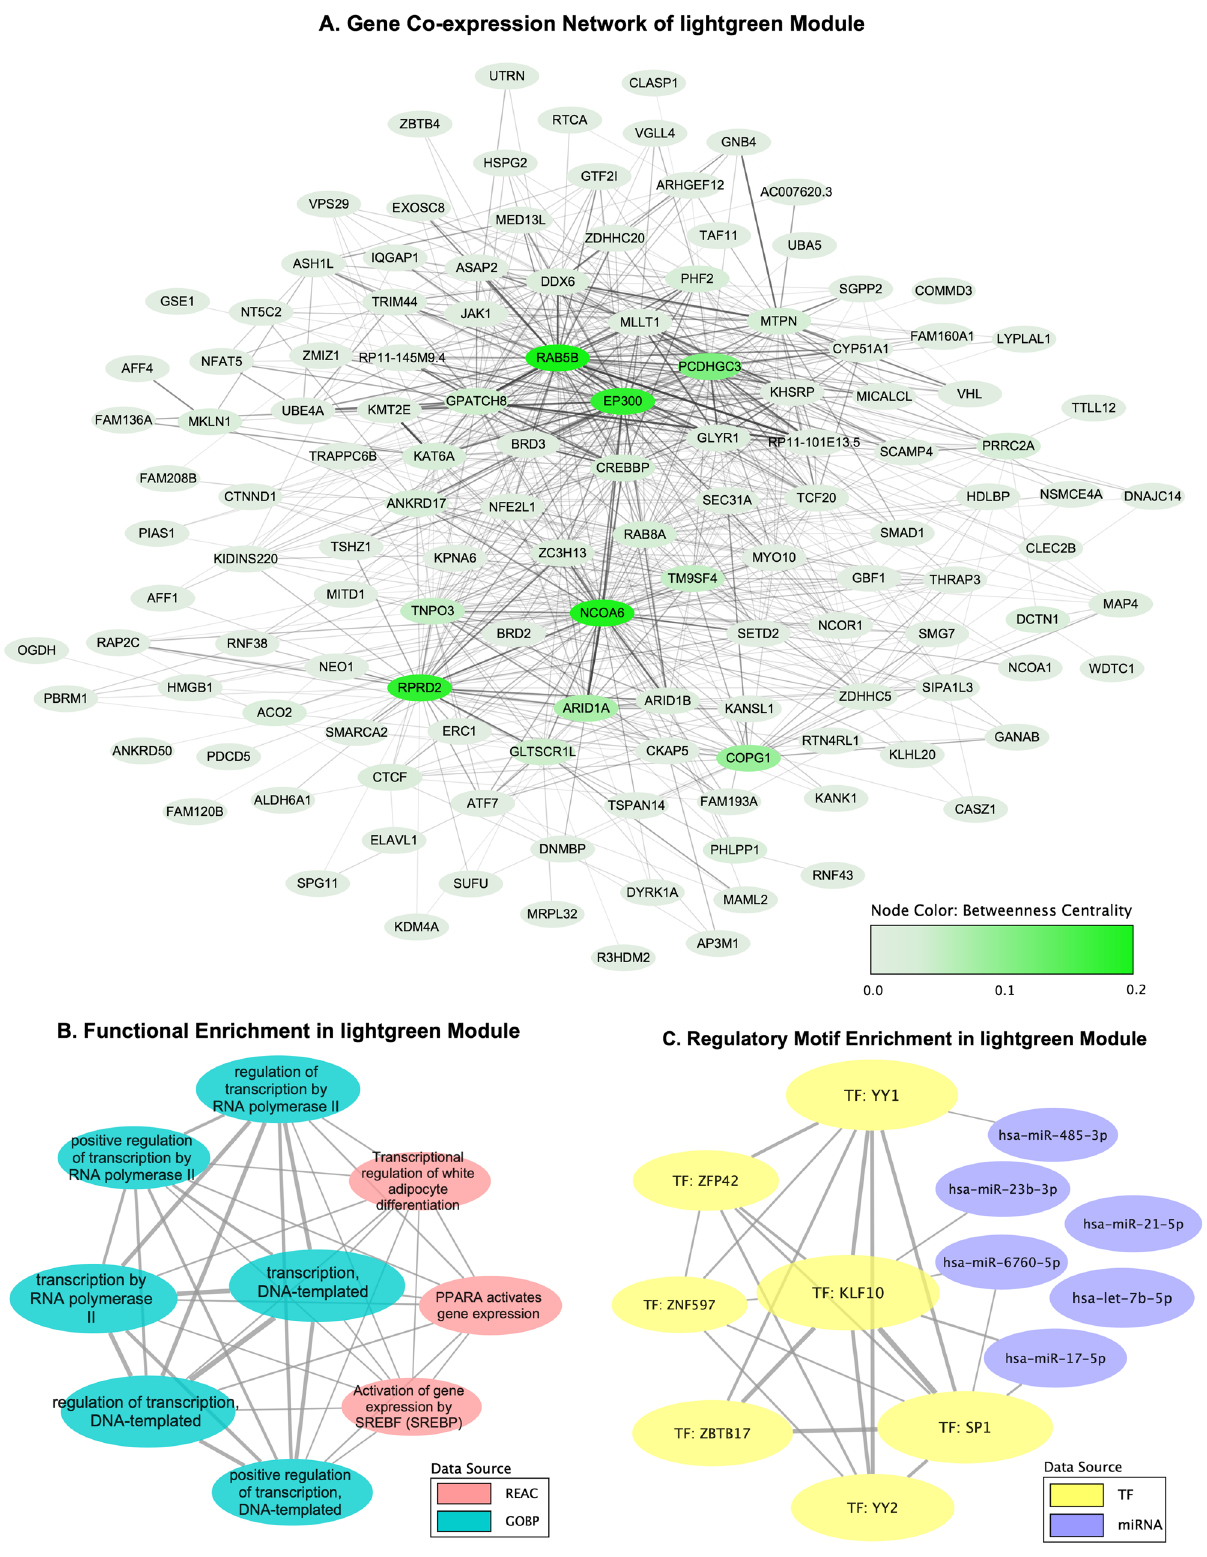
Figure 2. Intramodular analysis of lightgreen module. ( A ) Gene co-expression network of lightgreen module. ( B ) Functional enrichment of lightgreen module: each node is a gene set and the width of an edge represents the number of genes shared by every two gene sets. ( C ) Regulatory Motif enrichment of lightgreen module: each node is a gene set representing predicted targets of regulation by a TF or miRNA and the width of an edge represents the number of target genes shared by every two